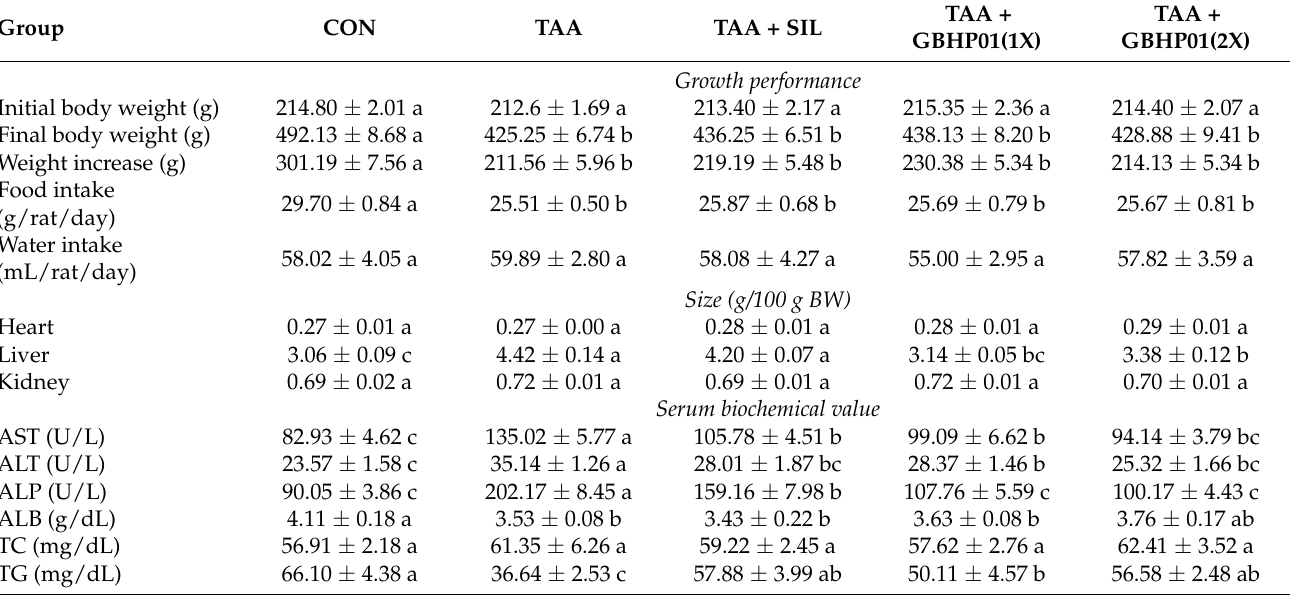
Table 1. Effects of chicken liver hydrolysate-based supplement (GBHP01 TM ) on growth performance, organ sizes, and serum biochemical values of experimental